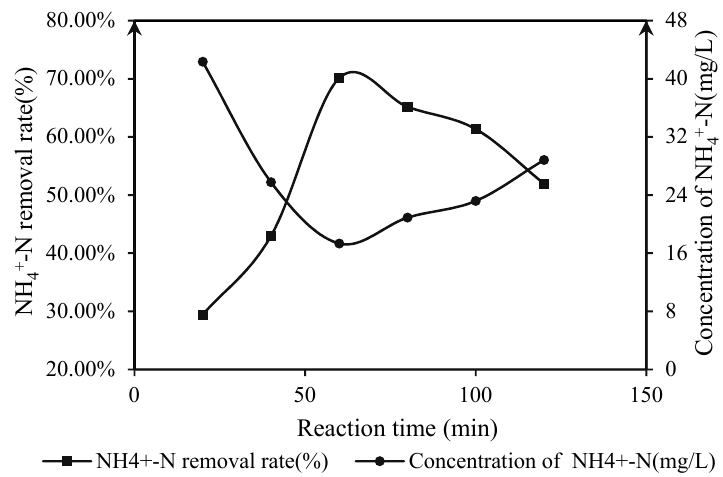
Figure 8. Water 2019 , 11 , 310